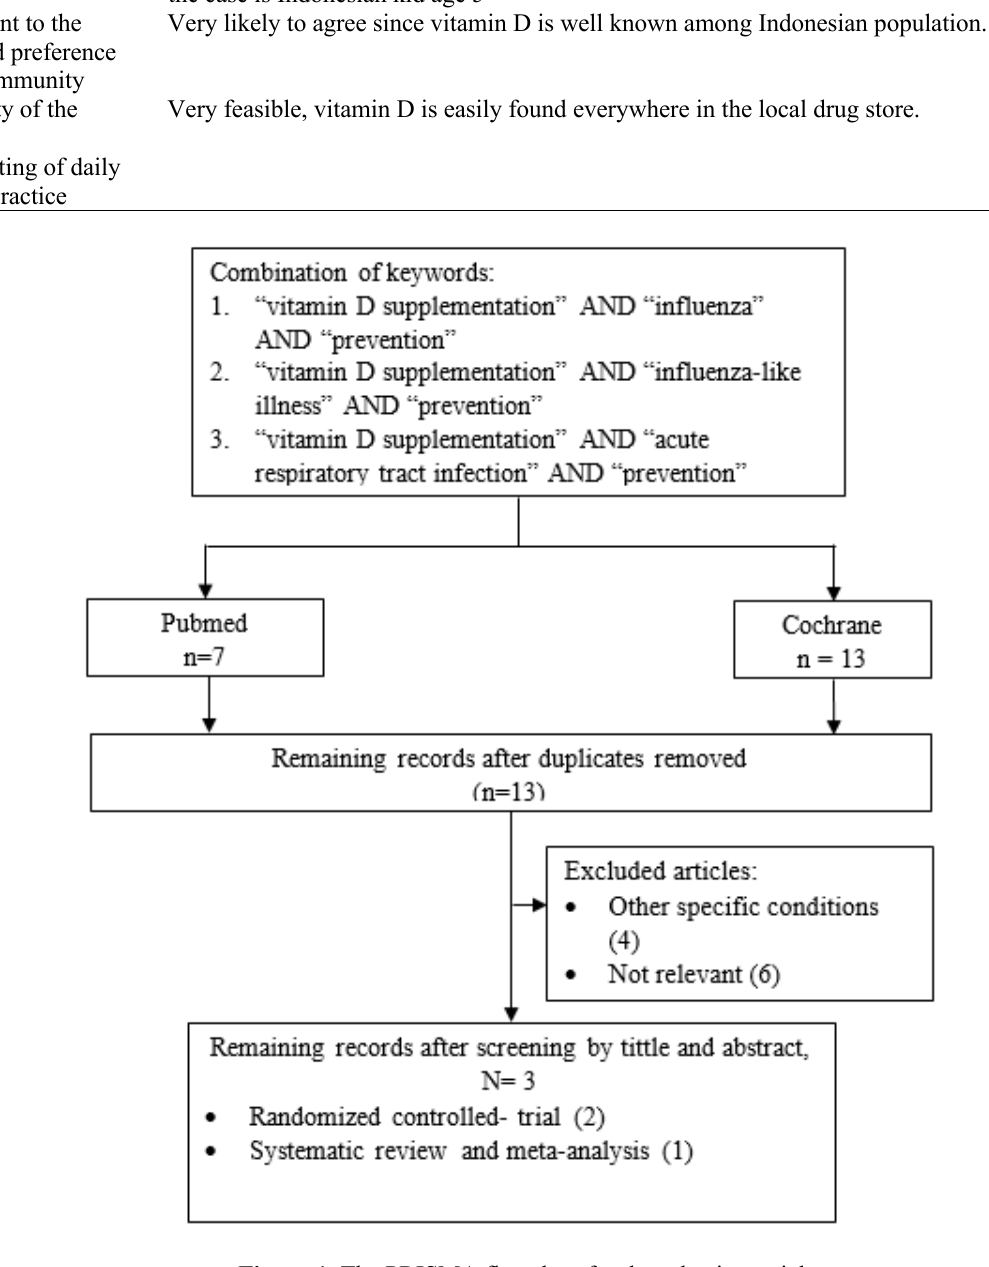
Figure 1. The PRISMA flowchart for the selection